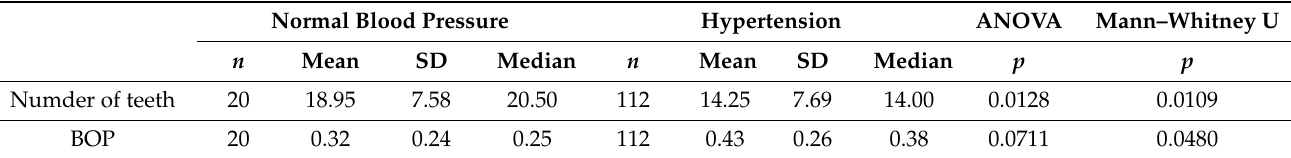
Table 9. Hypertension versus mean number of